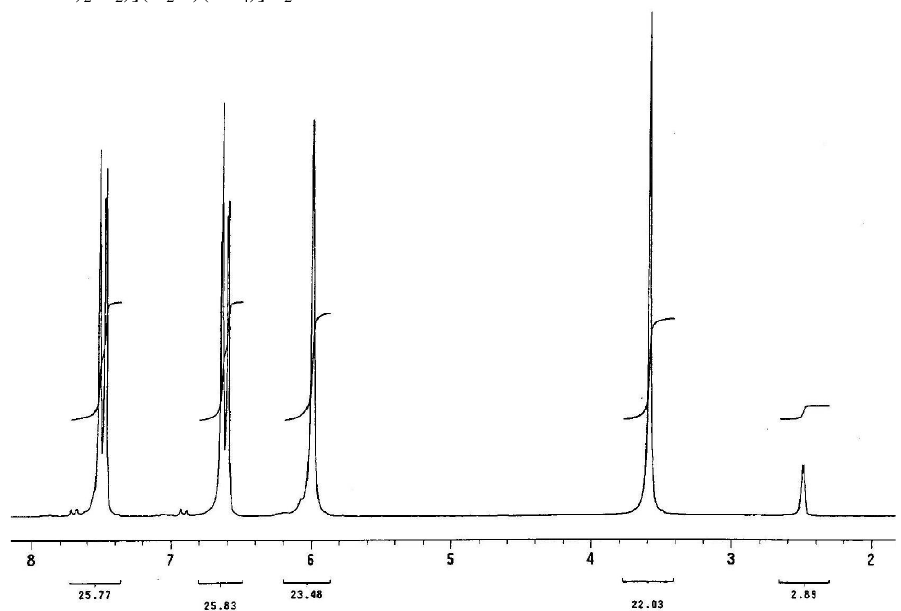
Figure 2. 1 HNMR Spectrum of 4,